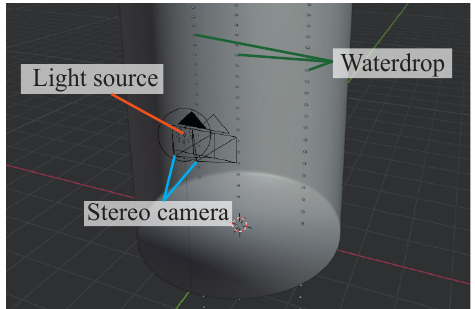
Figure 4. The simulated pedestal of Unit 2 in FDNPP for the experiment. A stereo camera was placed in the pedestal using a single light source. Waterdrops were dripping from above.